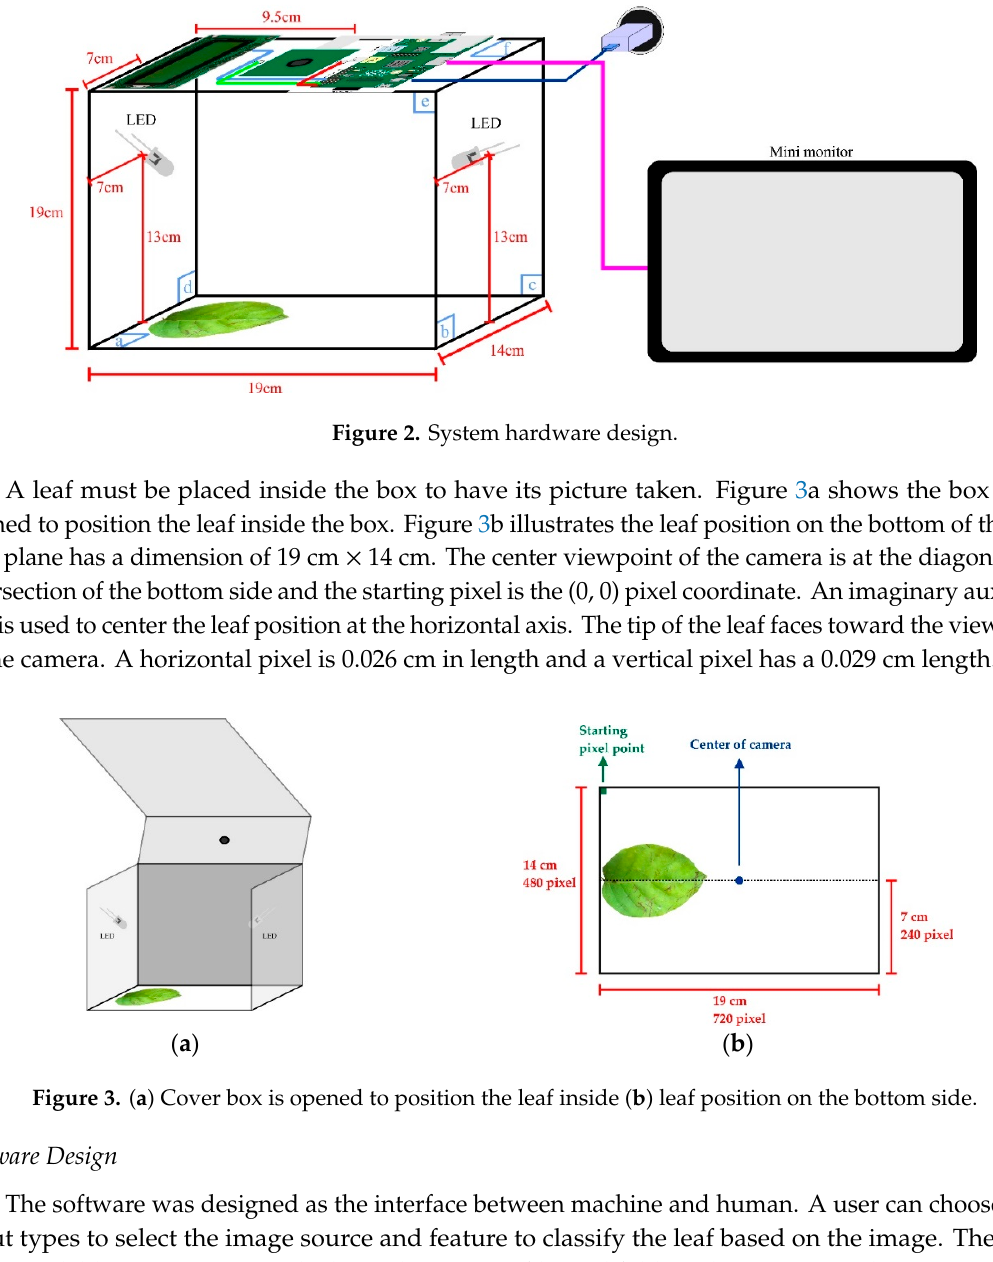
Figure 3. ( a ) Cover box is opened to position the leaf inside ( b ) leaf position on the bottom side.